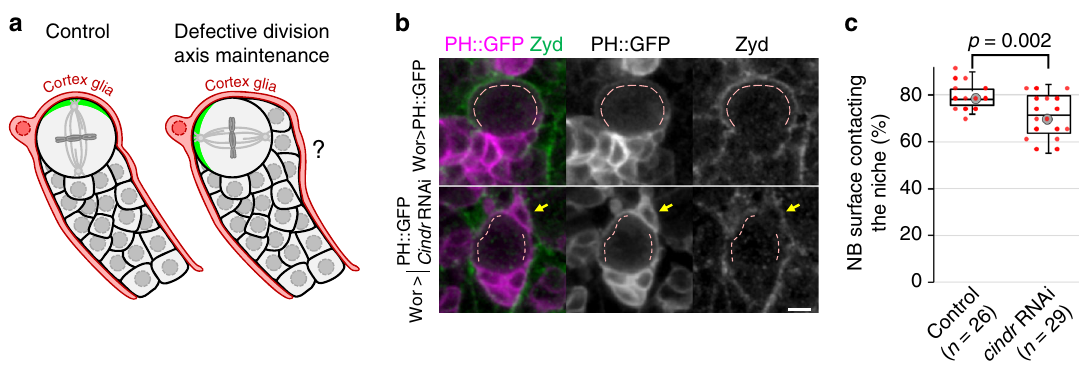
Fig. 6 Reduced NB/glial cell contact area in cindr RNAi NBs. a Schematic of how defective division axis maintenance might alter NB/cortex glia contact area. b Control and cindr RNAi-expressing NBs expressing Wor-GAL-driven PH::GFP and stained for the cortex glia membrane marker Zyd. Dashed lines: NB/cortex glia contact. Arrow: a cell belonging to the NB progeny (as it is ensheathed with it by the Zyd-positive glia) but positioned away from other GMCs produced by the same NBs. Scale bar: 5 µ m. c Percentage of the total NB surface in direct contact with the cortex glia cell in control and cindr RNAi- expressing NBs. Data from two independent GMCs (Supplementary Fig. 4a-b). In conclusion, speci fi c